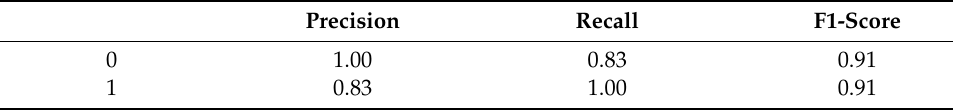
Table 9. Performance Metrics for Testing Data.